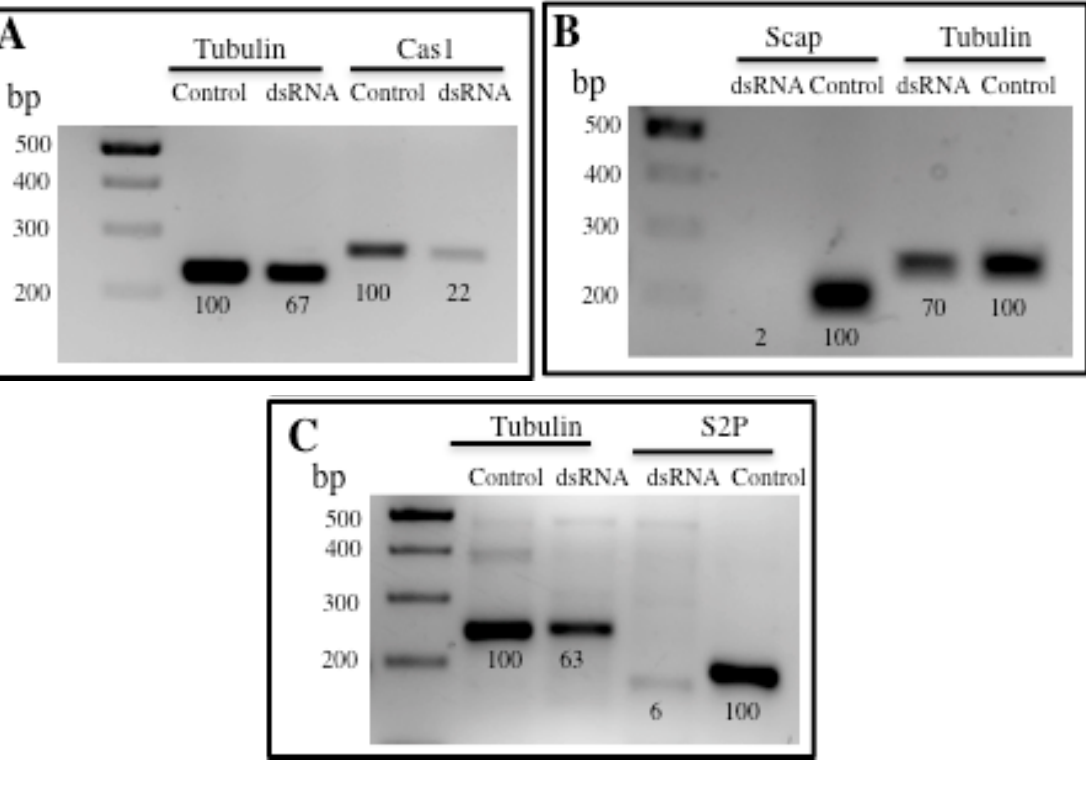
Figure 4. Silencing of SREBP pathway by RNAi in Aedes aegypti larvae. ( A ) The expression of cas -1 gene was analyzed by RT-PCR assays in larvae that were feed with cas 1-dsRNA and in control larvae; ( B ) The expression of scap gene was analyzed by RT-PCR assays in larvae that were feed with scap -dsRNA and in control larvae; ( C ) The expression of s2p gene was analyzed by RT-PCR assays in larvae that were feed with s2p -dsRNA and in control larvae . Numbers under the bands are percentage in relation to the control band, after densitometry analysis. The control bands correspond to non-silenced larvae and were considered as 100%. Expression of tubulin was used to normalize the